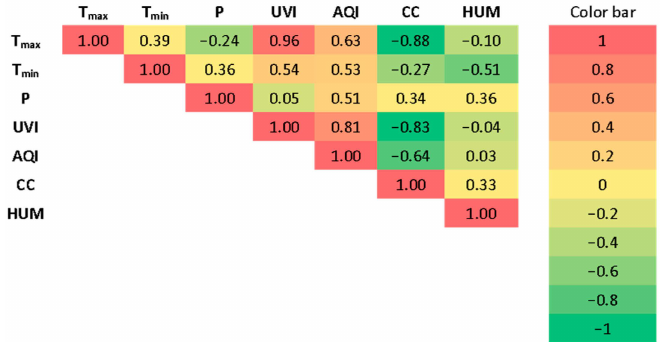
Figure 4. Statistical correlation matrix between the collected meteorological data from 21 November to 22 March 2022.